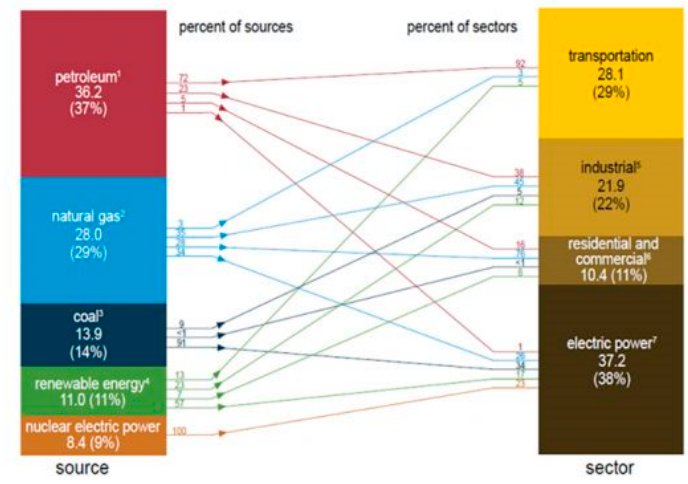
Figure 3. U.S. primary energy consumption by source and sector, 2017 [59].